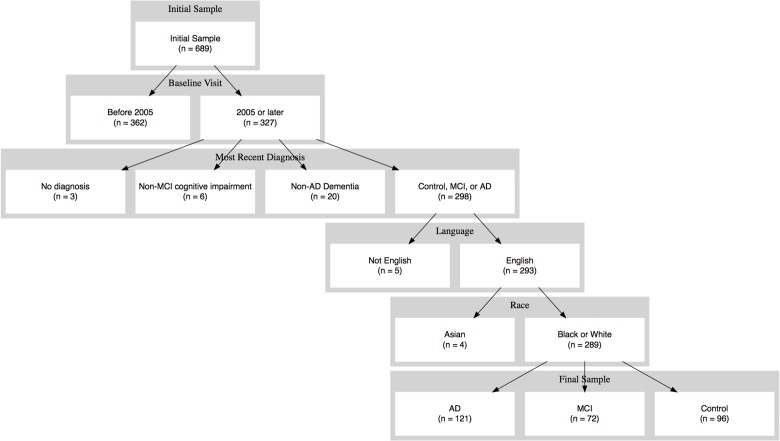
Participant Flow.Flowchart illustrating application of inclusion and exclusion criteria for the current study.